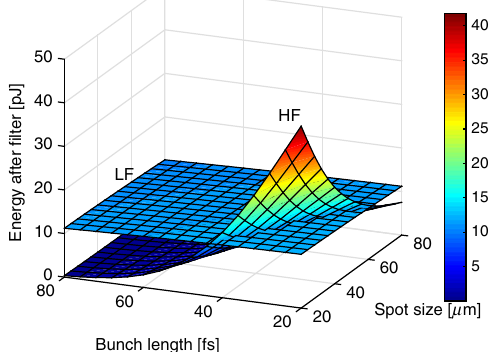
FIG. 5. Filtered energy for different bunch size ( σ bunch length ( σ , rms). The HF and LF denotes the energy after t high frequency filter and low frequency filter, respectively. The charge is 1 pC.